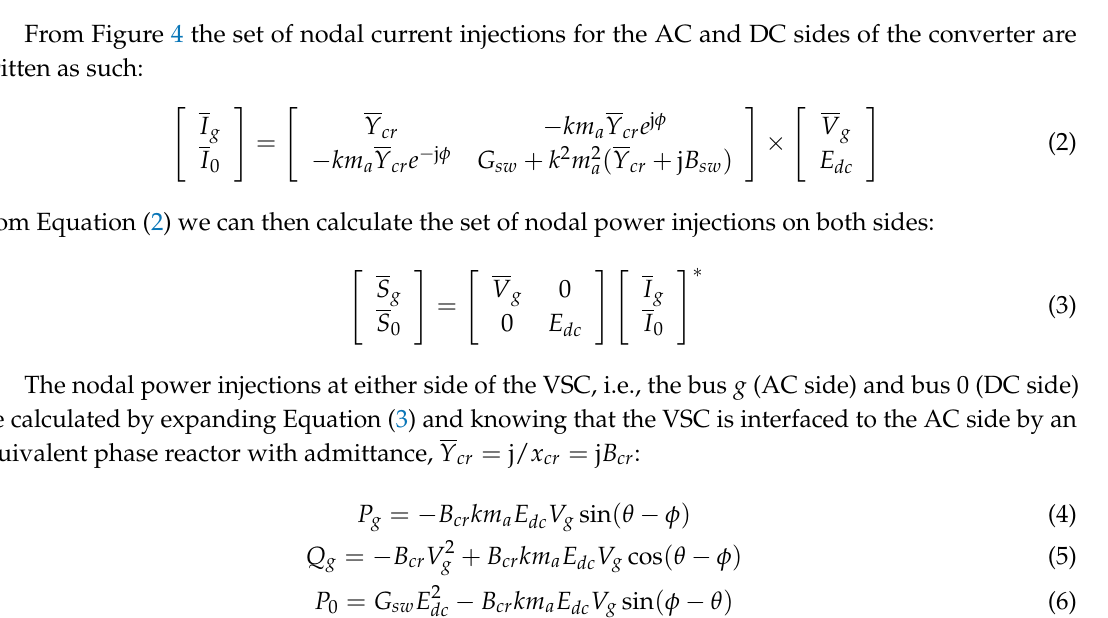
Figure 4. The equivalent VSC (voltage source converter) fundamental frequency